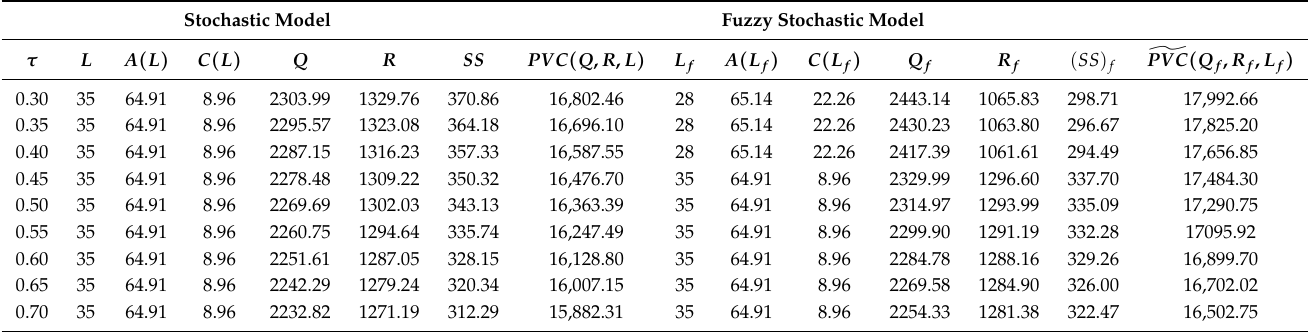
Table 9. Effect of the back order cost in the stochastic and fuzzy stochastic models.